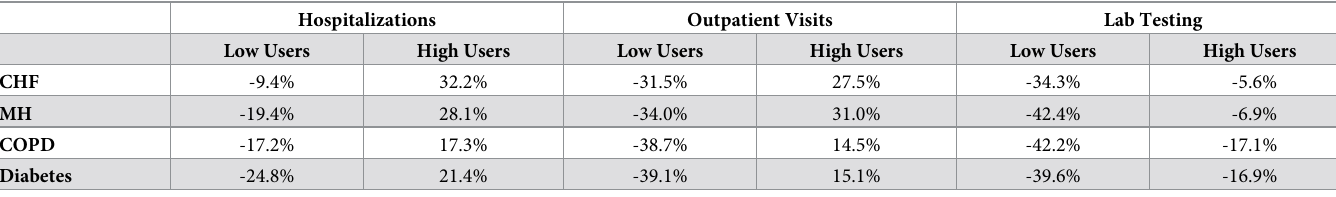
Table 2. Percent change in the average number of hospitalizations, outpatient visits and lab testing from pre to post Mar 14,